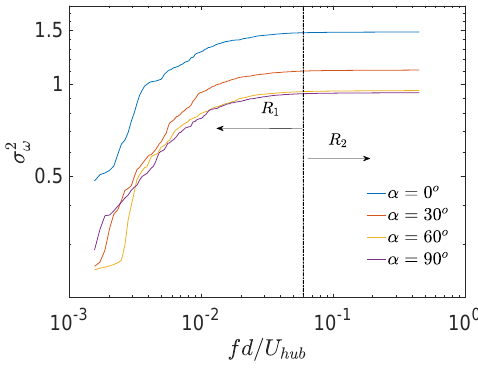
Figure 5. Integrated energy σ 2 ω of large-scale rotation speed fluctuations subjected to various α